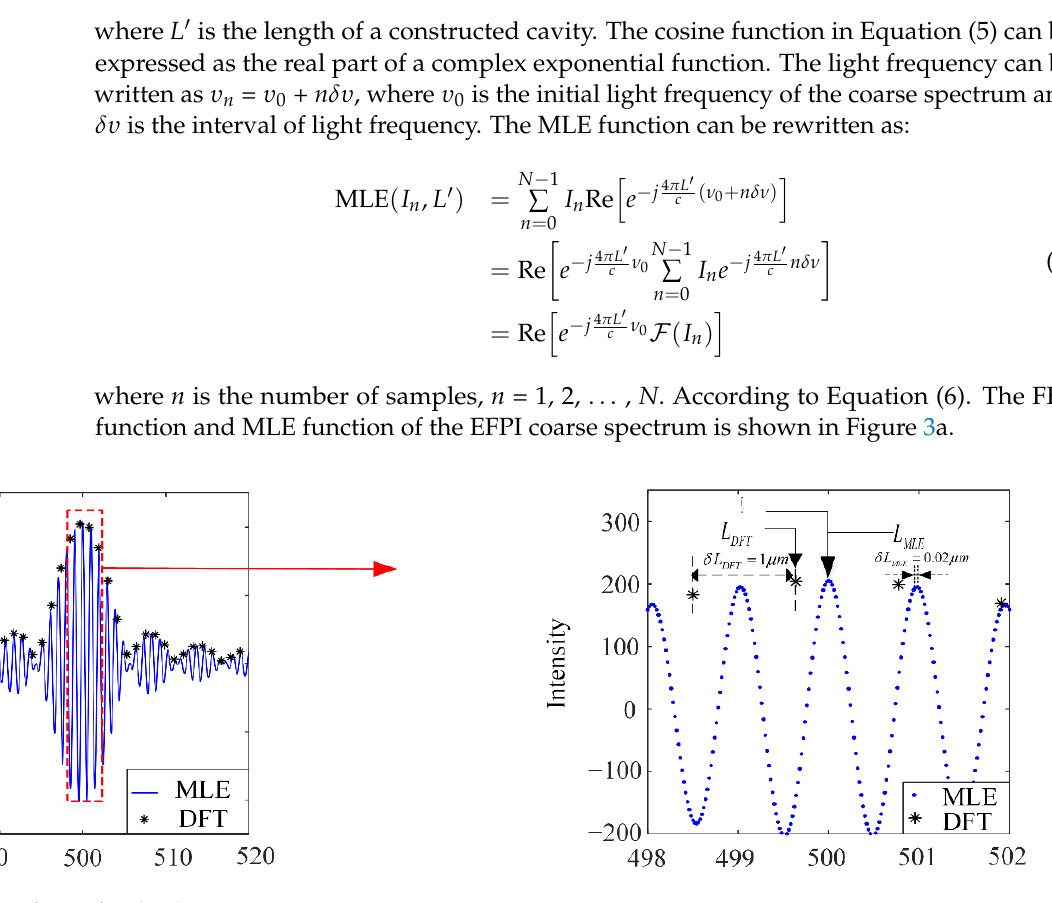
Figure 4. The implementation steps of the MLE algorithm: ( a ) FFT rough estimate and ( b ) MLE fine estimate (Assuming L = 500 μ m).